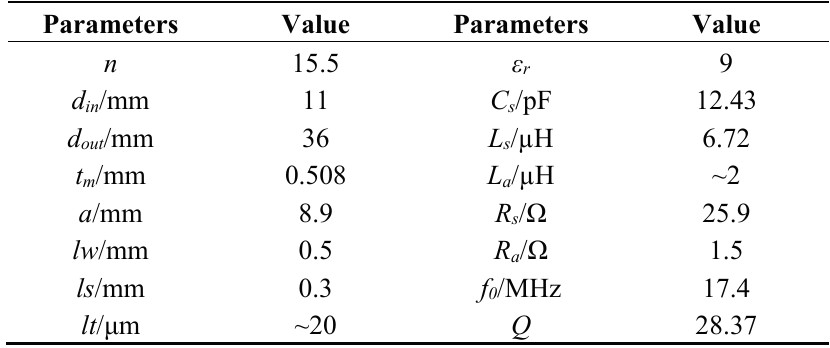
Table 1. Design parameters at room temperature (25